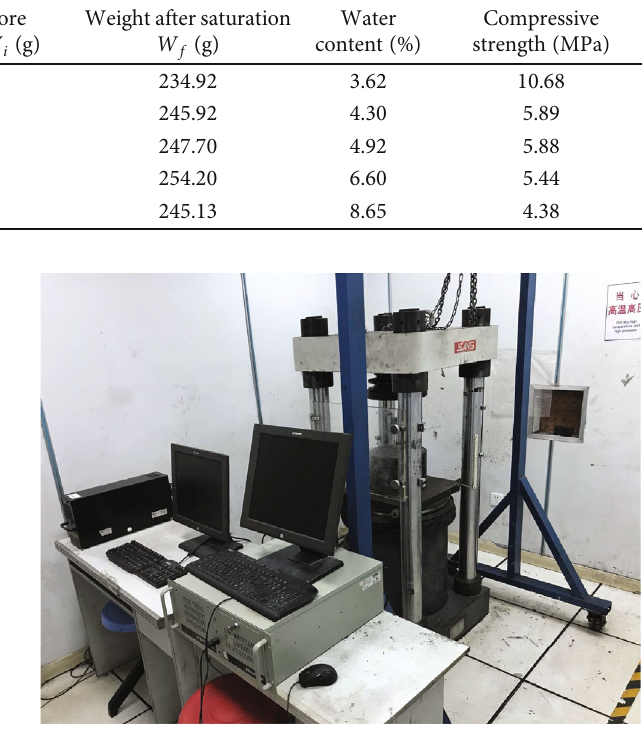
Figure 3: Loading experimental system.